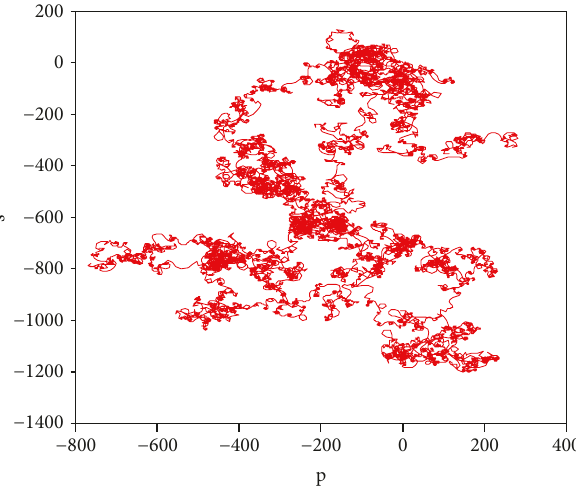
Figure 11: The dynamics of the translation components p − s of system (2) with a = 28 , b = 7 , and δ = 0 02 .